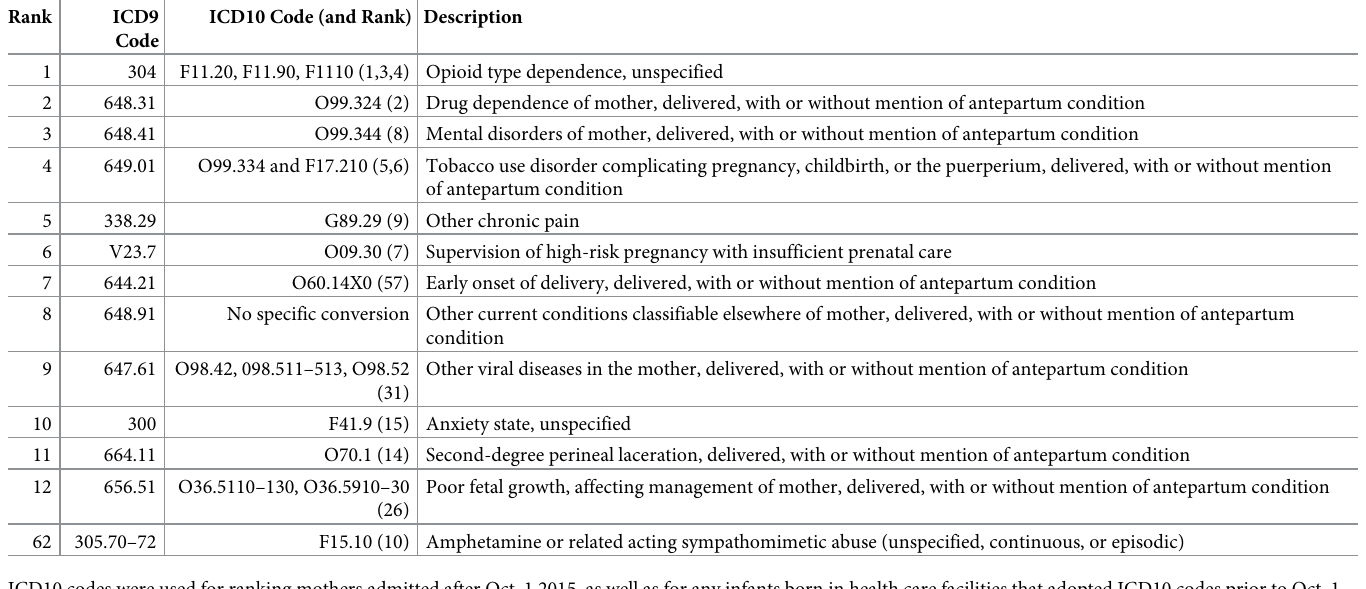
Table 3. Top ranked ICD9 and ICD10 codes associated with mothers who are opioid dependent at the time of giving birth. Rank ICD9